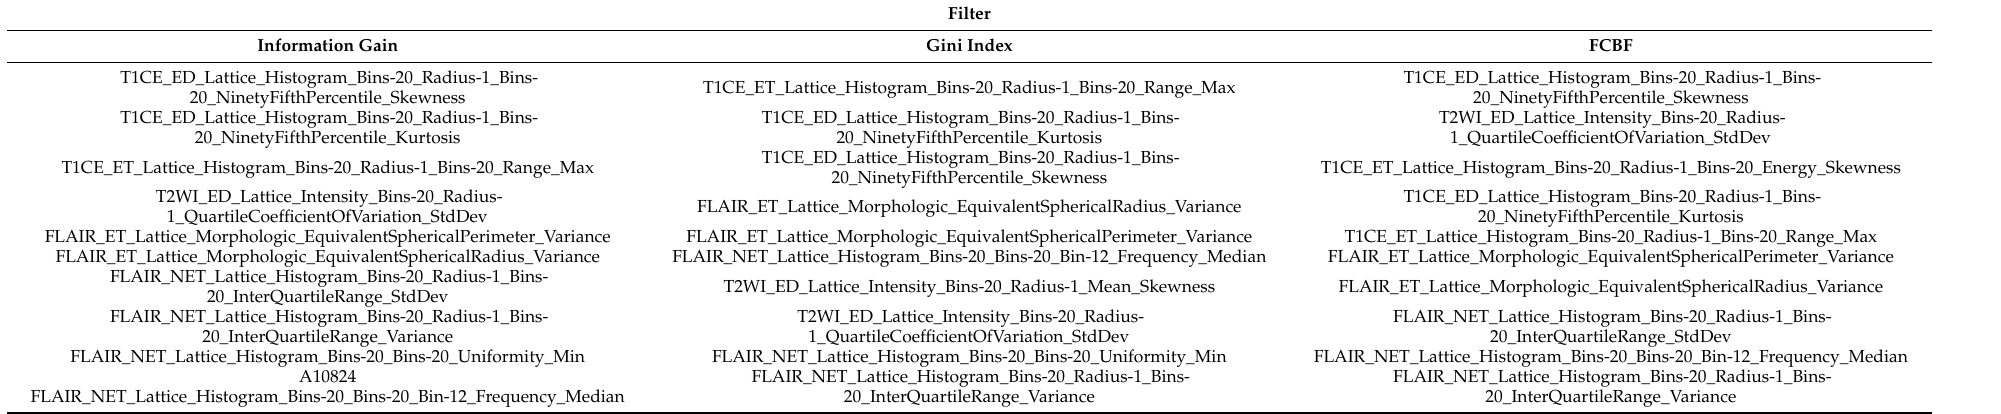
Table 2. Radiomic features ranked by different scoring methods for short-term survival